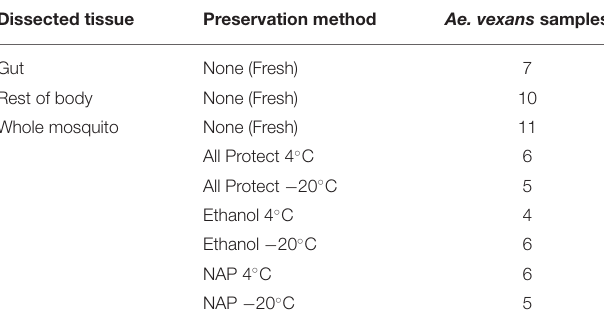
TABLE 1 | List of processing treatments and number of samples used in the